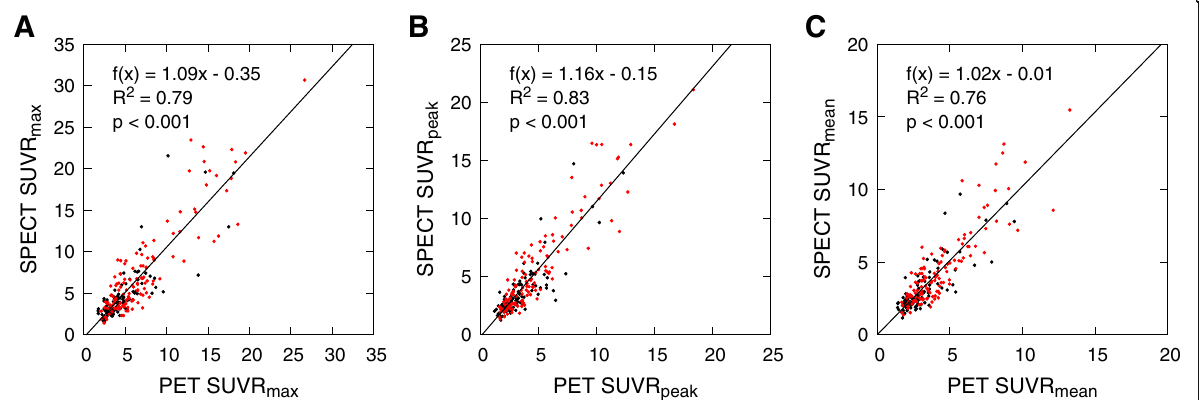
Fig. 4 Scatter plots of a SUVR max , b SUVR peak , and c SUVR mean from SPECT and PET data for all lesions. Metastatic lesions are marked in red and benign in black. Regression lines with slopes, y -intercepts, and coefficients of determination ( R 2 ) have been calculated using the method of least squares